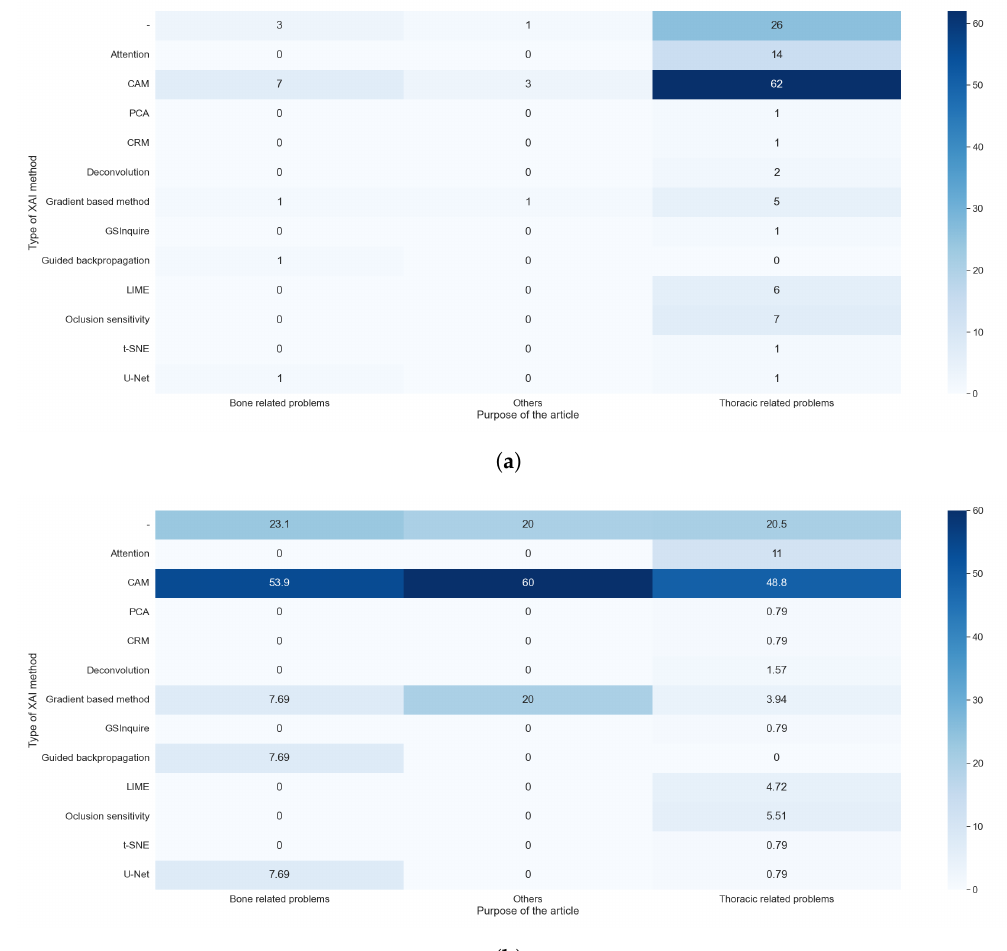
Figure 11. Heat maps comparing the results of RQ1 and RQ5. All articles that did not indicate the type of XAI method used are shown. ( a ) In absolute values; ( b ) normalized results by column.